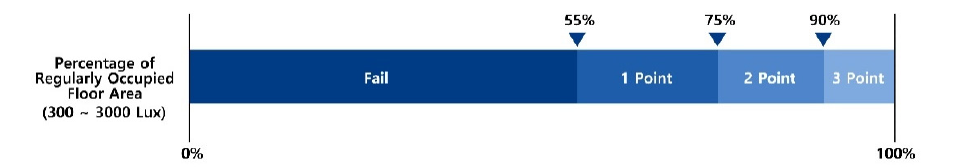
Figure 2. LEED v4.1 daylight option 2 criteria (reconstructed the Daylight evaluation of LEED v4.1 Building Design and Construction).